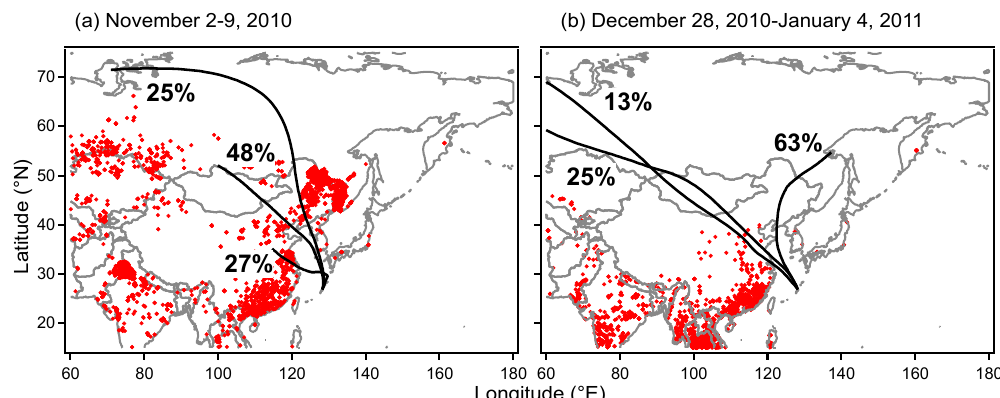
Figure 4. Air mass origins for the events of elevated anhydrosugars corresponding to I and II in Fig. 3 on (a) 2–9 November 2010 and (b) 28 December 2010–4 January 2011, respectively. Clusters of 5-day backward trajectories arriving at 500ma.g.l. at Cape Hedo, Okinawa, are given. The numbers in each panel indicate the percentages of hourly trajectories in the events with such origins. Fire spots in East Asia during (a) 28 October–9 November 2010 and (b) 23 December 2010–4 January 2011 are also shown.